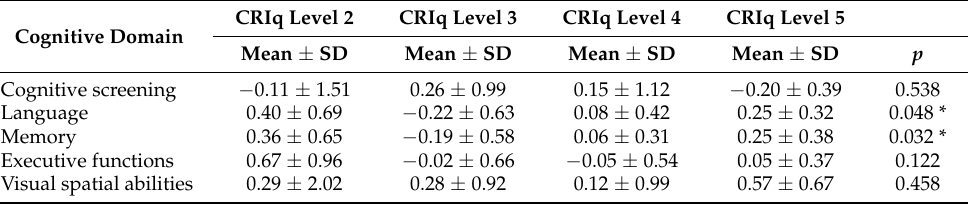
Table 5. Univariate ANOVA between groups identified according to CRIq level on global neuropsy- chological performances (controlling for disease